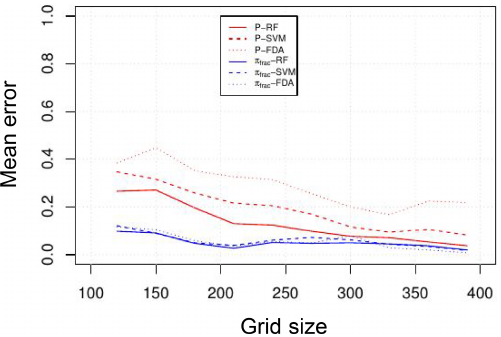
Figure 17. Mean error of three different ML classification algo- rithms (random forests, supported vector machine, and flexible dis- criminant analysis) as a function of the domain size (figure from Monterrubio-Velasco et al.,